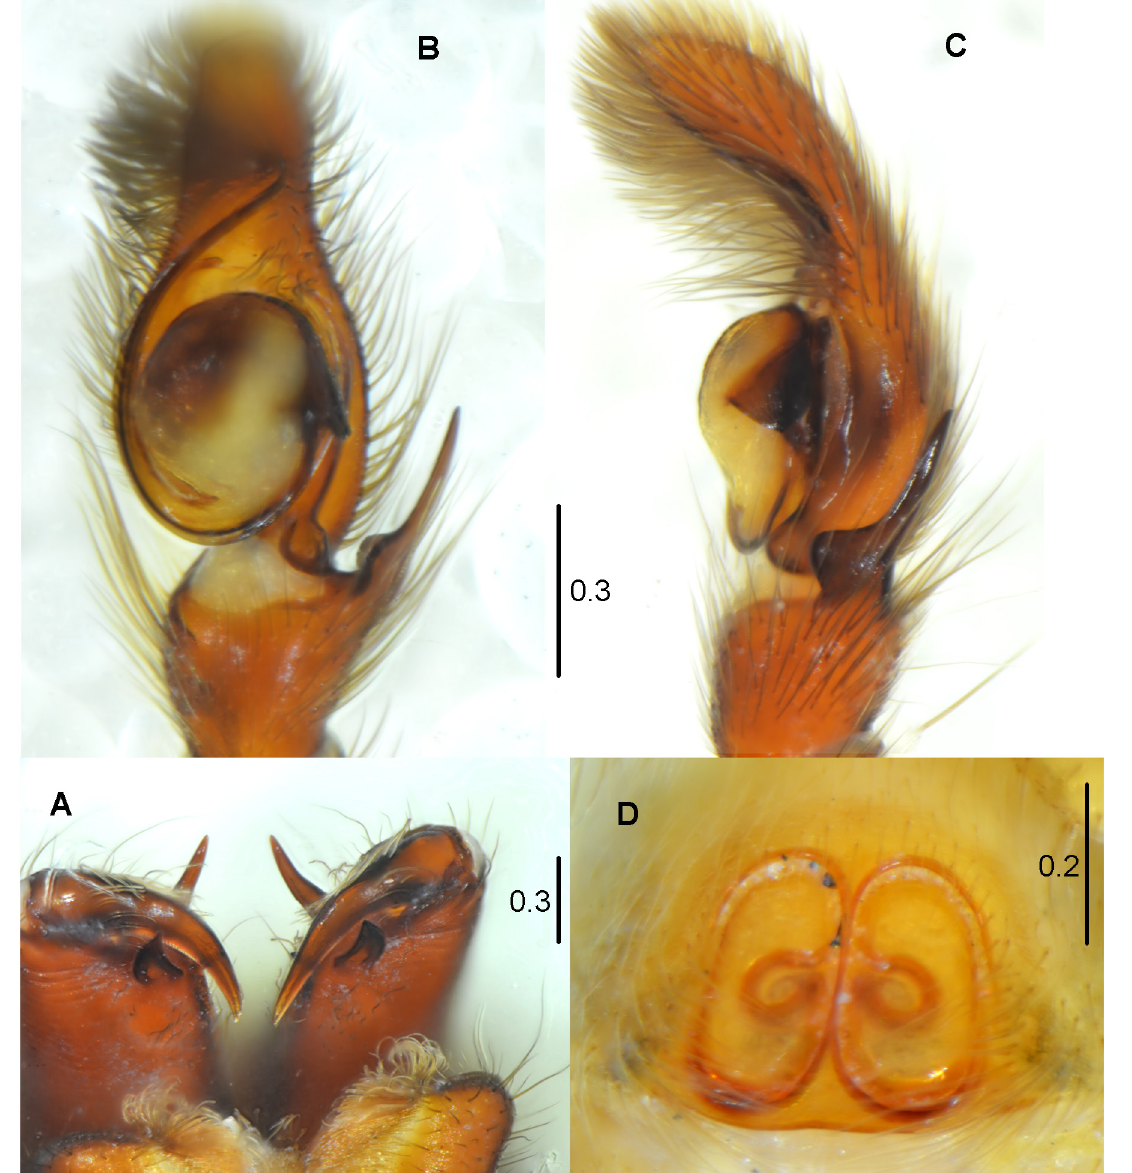
Fig. 6. Bacelarella dracula Szűts & Jocqué, 2001, ♂♀ (MNHN). A . Male chelicera. B . Palpal organ, ventral view. C . Palpal organ, lateral view. D .